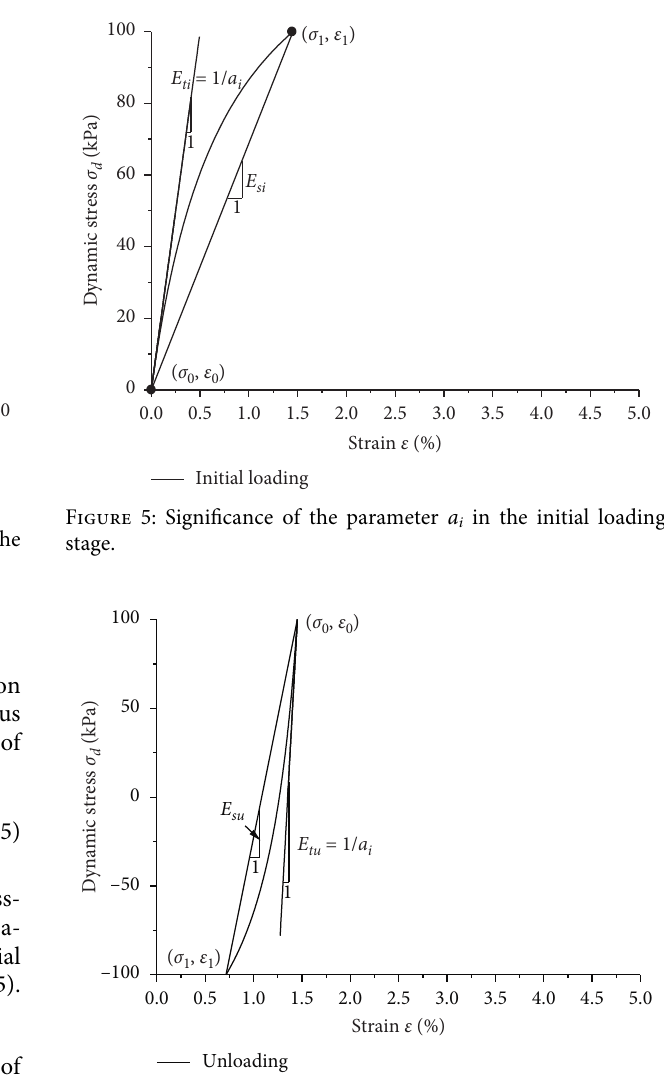
Figure 6: Significance of the parameter a